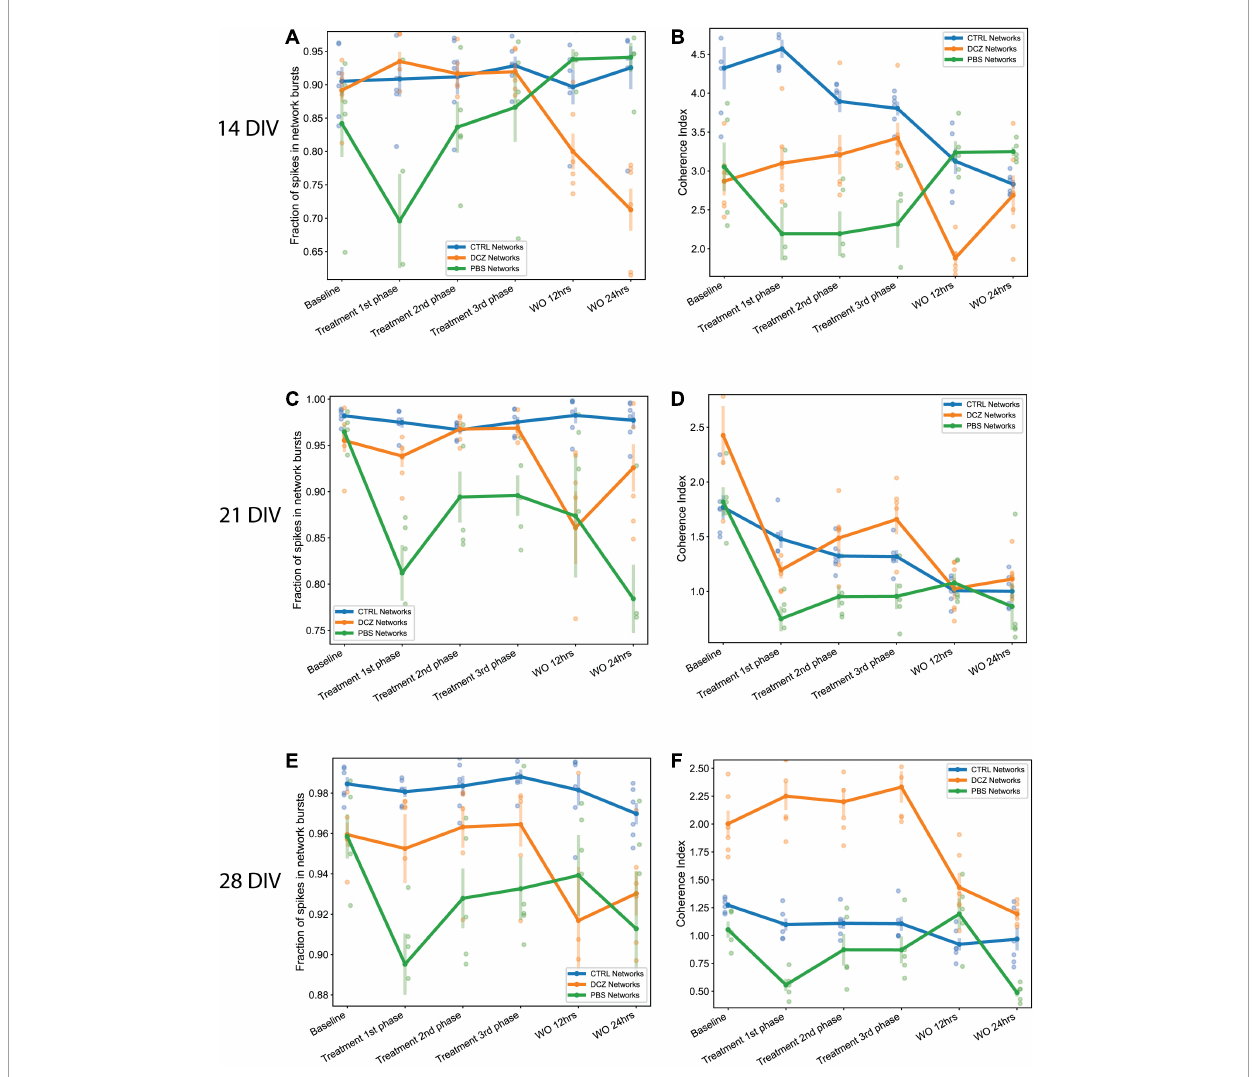
FIGURE8 The fraction of spikes in network bursts and the measure of network synchrony across the baseline, treatment and recovery recordings at 14, 21, and 28 DIV. (A,C,E) Plots showing the fraction of spike in network bursts. The x -axis denotes the recording condition, and the y -axis denotes the percentage of spikes in network bursts. (B,D,F) Plots showing the coherence index ( y -axis) of each network group across each recording condition ( x -axis). The solid lines and solid circles plot the mean values for all networks in one group ( n = 6 for CTRL and DCZ, and n = 5 for PBS), the shaded bars show the standard error of the mean, and the shaded circles show the individual data